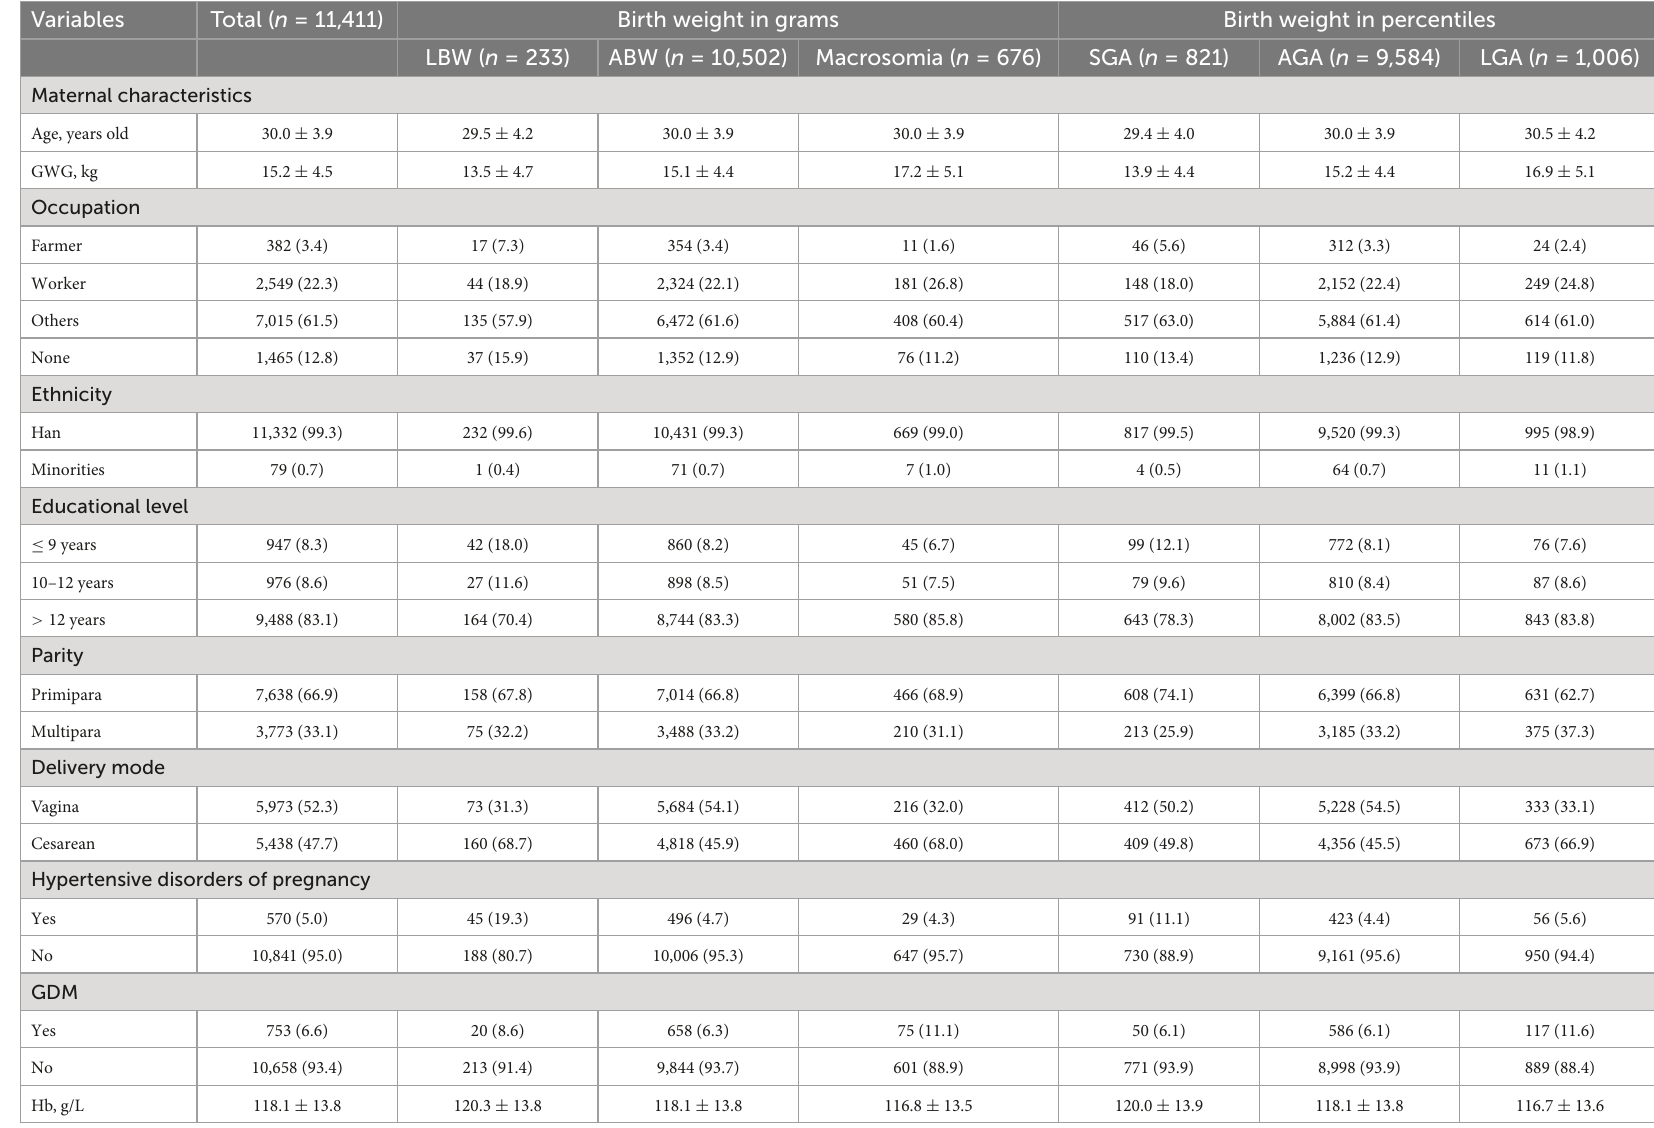
TABLE 1 Descriptive characteristics of the study population ( n =